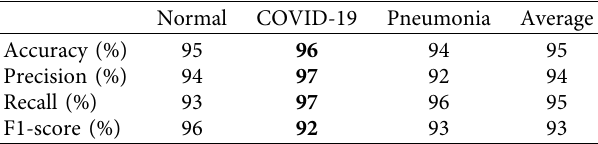
Table 5: Estimated performance metrics for the 3-set classification.